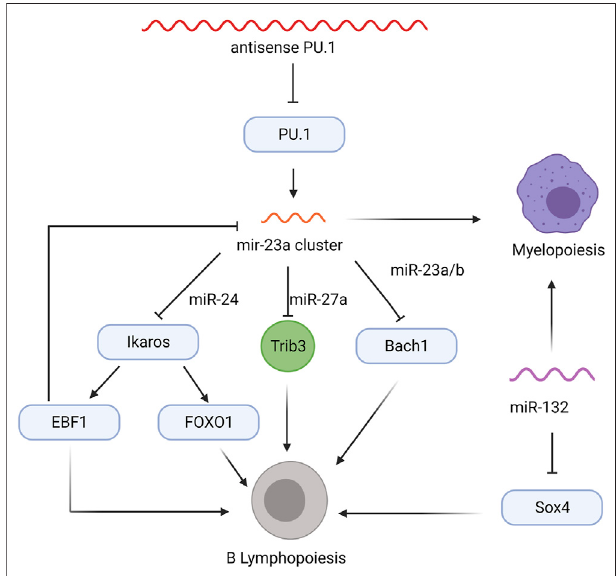
FIGURE 2 | Non-coding RNA regulatory network in MPPs that in fl uence myelopoiesis and B lymphopoiesis. Transcription factors are indicated in blue ovals, the Trib3 kinase is shown in green circle, and regulatory RNAs are colored wavy